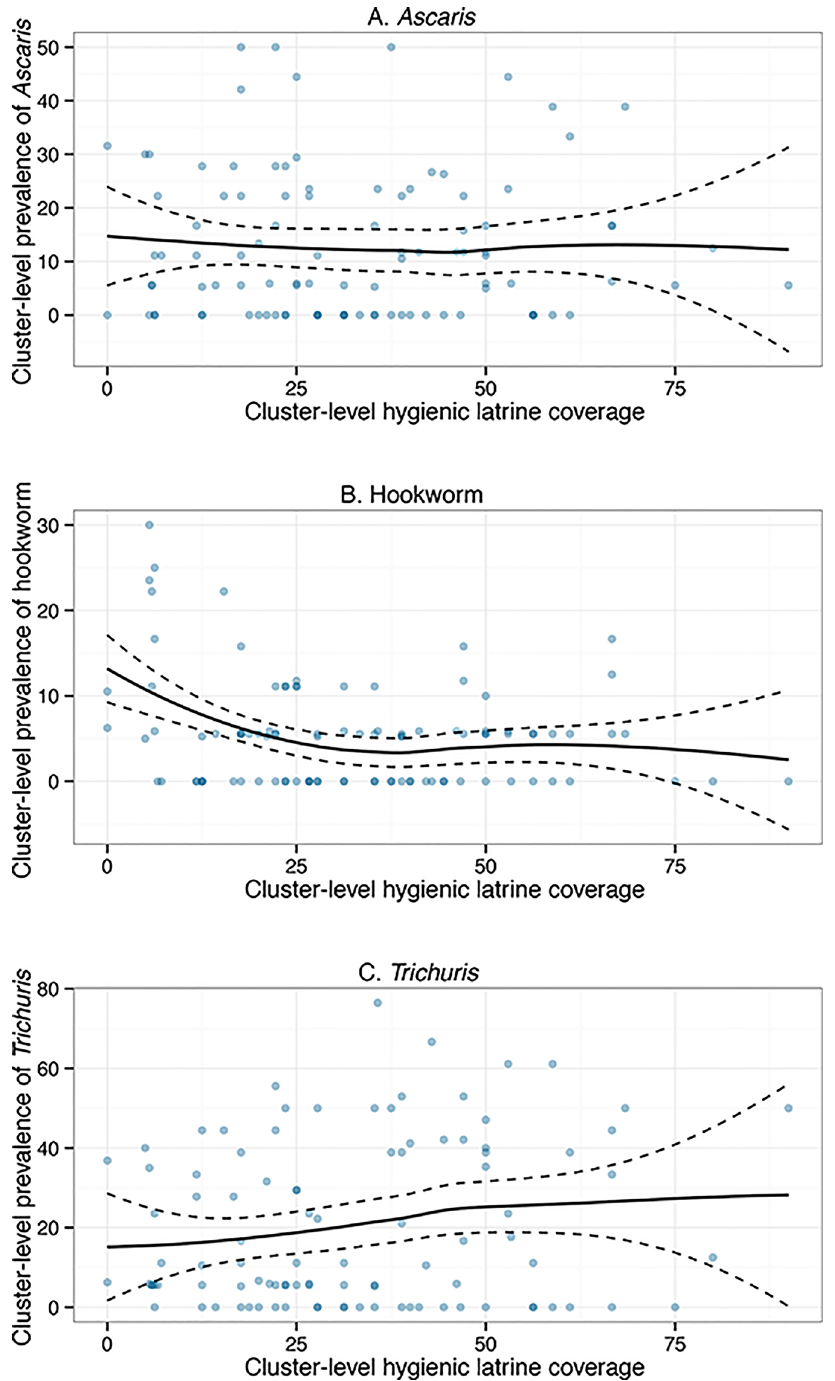
Fig 4. Cluster-level STH prevalence by cluster-level hygienic latrine coverage. Panel A shows the cluster-level prevalence of Ascaris , Panel B shows the prevalence of hookworm, and Panel C shows the prevalence of Trichuris by the proportion of respondents with hygienic latrines in each cluster.